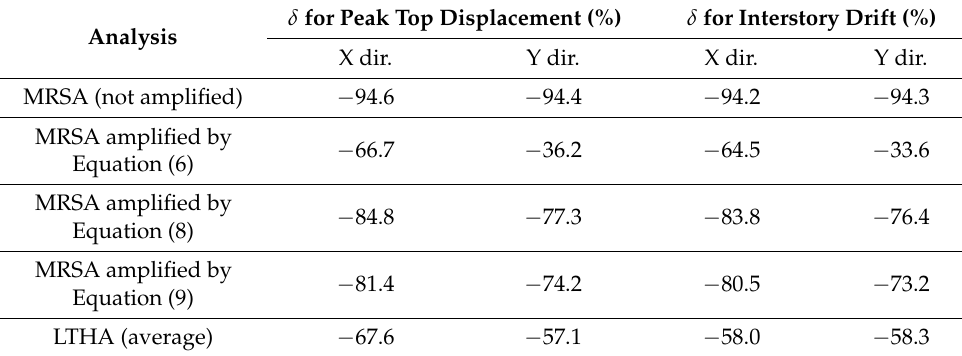
Table 7. Discrepancy δ calculated by means of Equation (10).